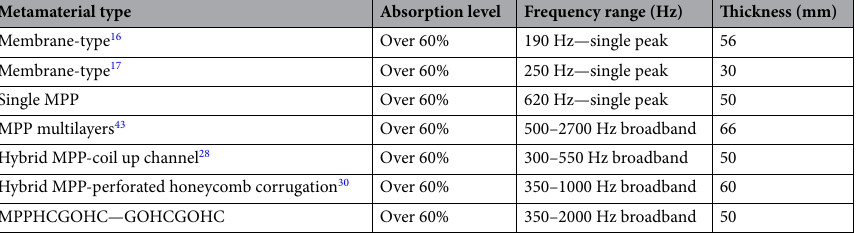
Table 4. Comparison of sound absorption characteristic for the proposed GOHCGOHC-MPPHCGOHC and other relevant acoustic metamaterial-absorber.